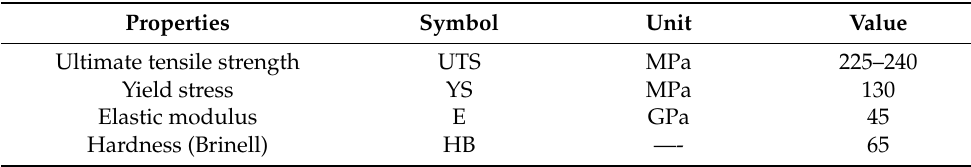
Table 2. Mechanical properties of AM60 magnesium alloy